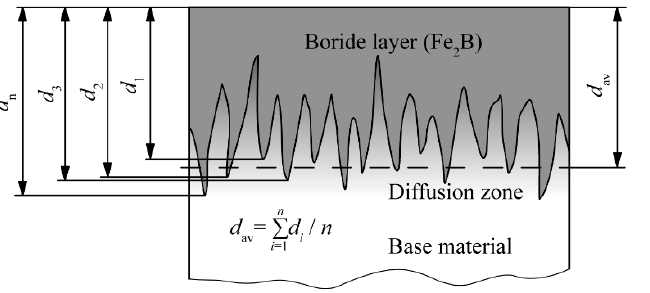
Figure 1. Determination of the boride layer thickness [43]. Reprinted with permission from ref. [43]. Copyright 2012 Mechanical Engineering Faculty in Slavonski